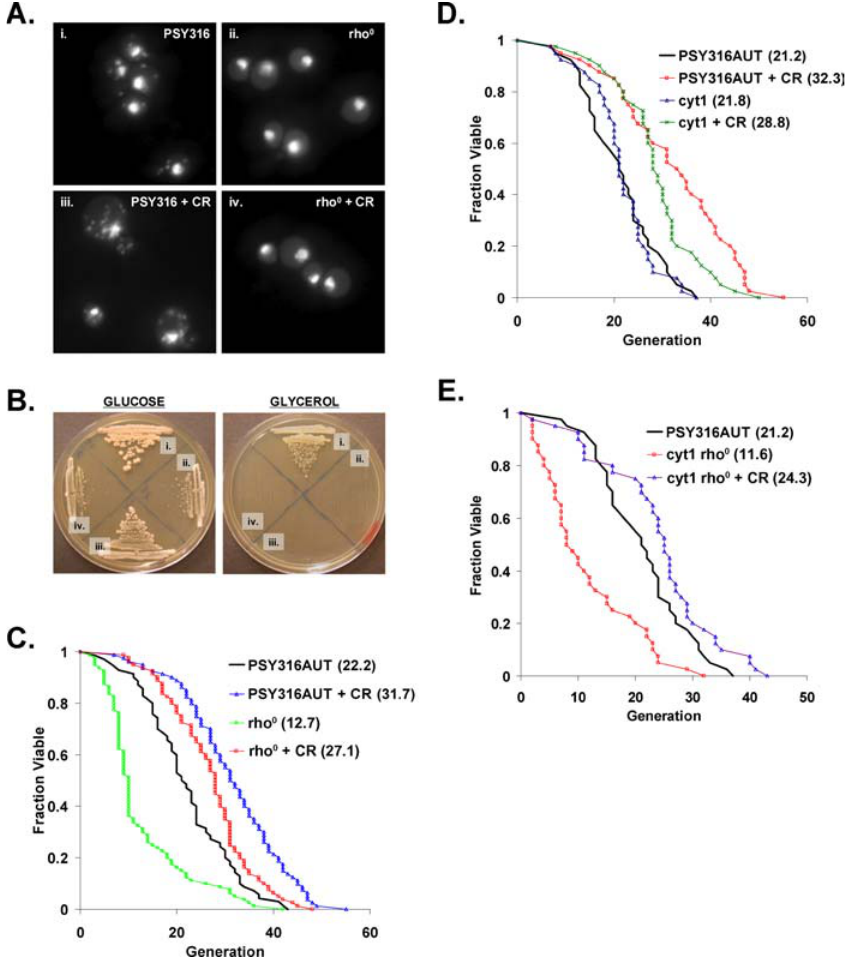
Figure 2. Respiration Is Not Required for Life Span Extension by CR in